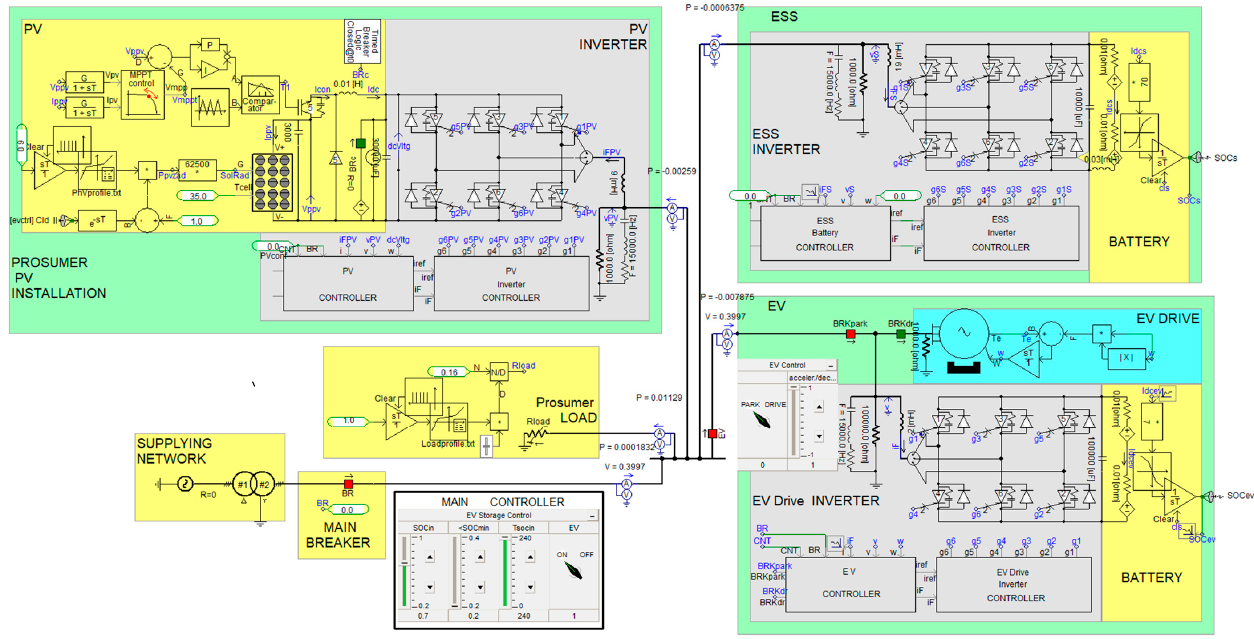
Figure 3. Schematic diagram of EV and home installation simulator